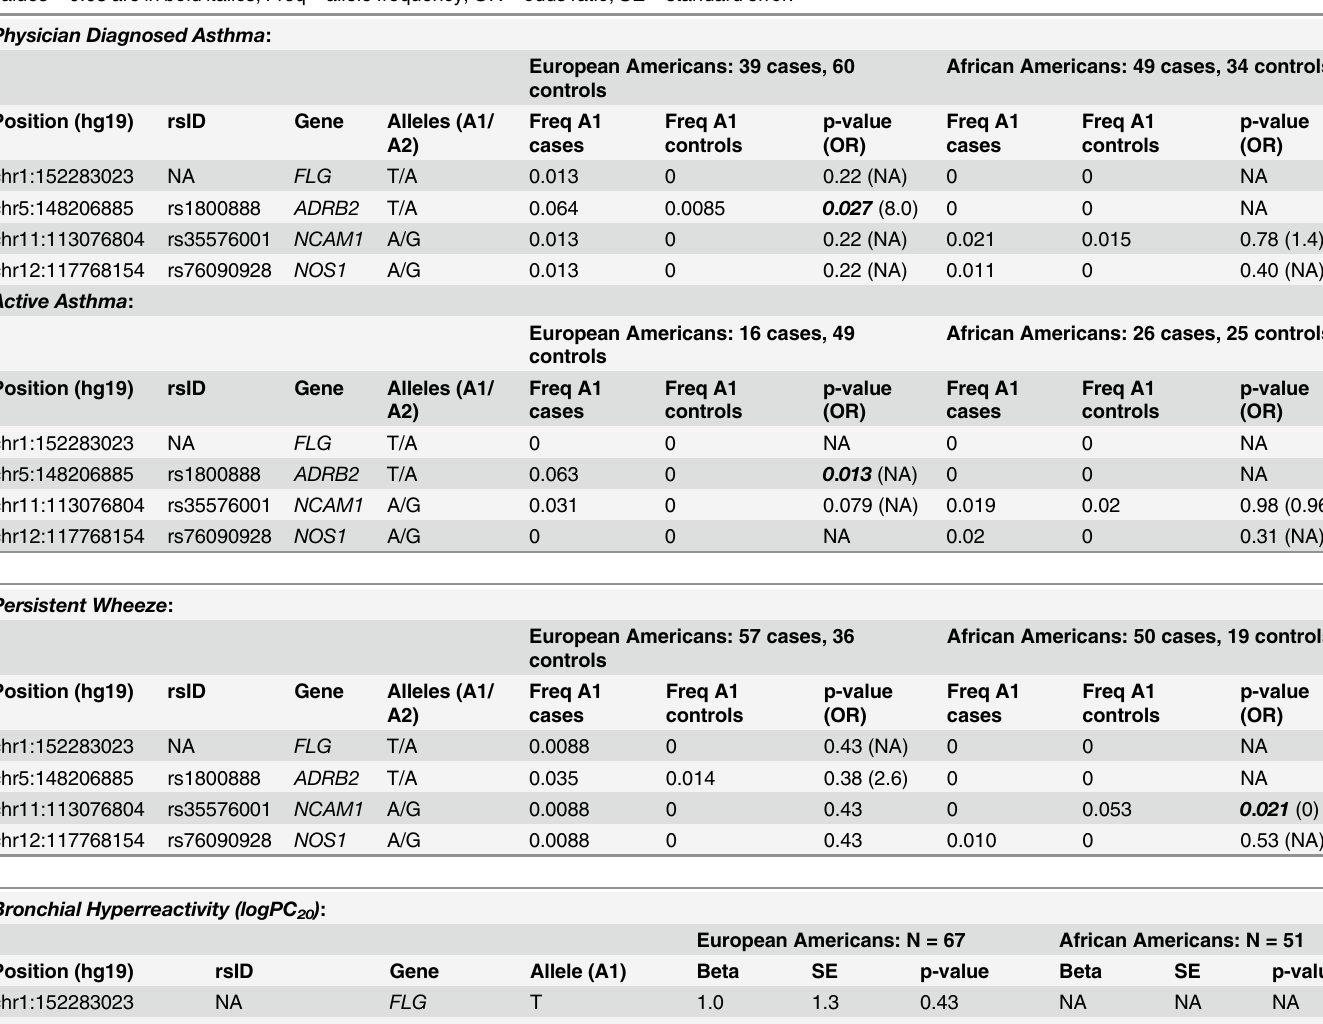
Table 5. Results of further association testing of candidate variants within individuals with severe RSV bronchiolitis in infancy, without including genotypes from the ESP. Phenotypes include physician diagnosed asthma, active asthma, persistent wheeze, and methacholine PC 20 at age 6 years.